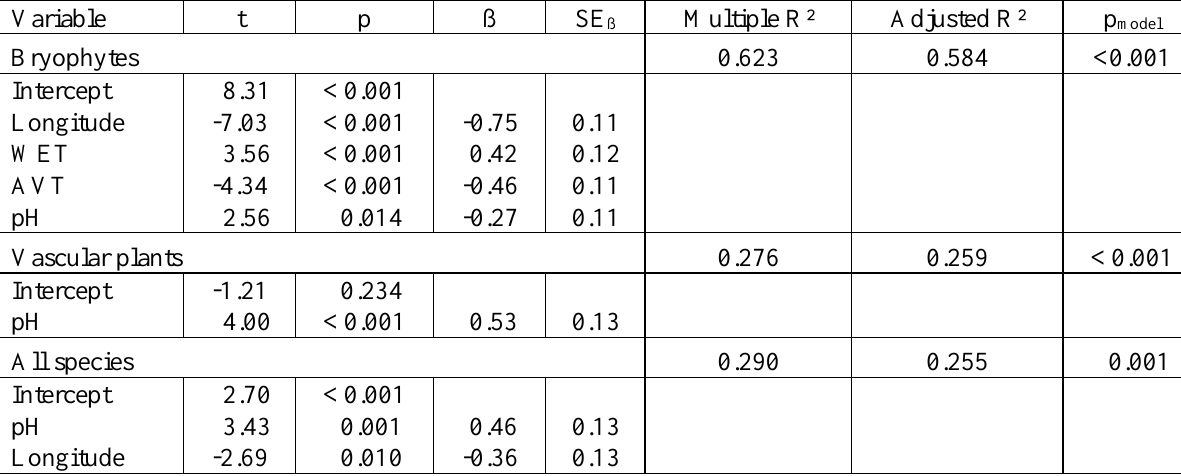
Table 2. Effects of environmental factors on the species richness in quagmire communities according to the General Regression Model analyses. Notation: t = value of the t-criterion by stepwise inclusion of variables into the GRM model; p = significance level; ß = standardised regression coefficient; SE = its standard error; ß Multiple R², Adjusted R² and p = statistics and significance level of the whole GRM model; Longitude = model plant community centre longitude coordinates; pH = peat-water pH; WET = lake water exchange type; AVT = adjacent vegetation type.